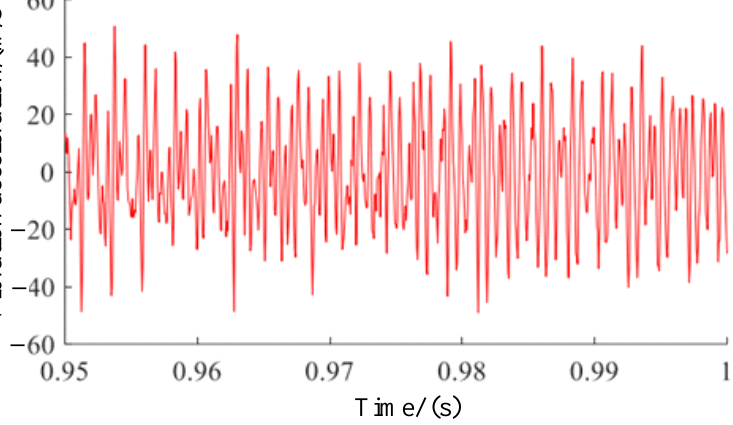
Figure 13. Time domain variation result of the equipment vibration under the fixed load and speed.